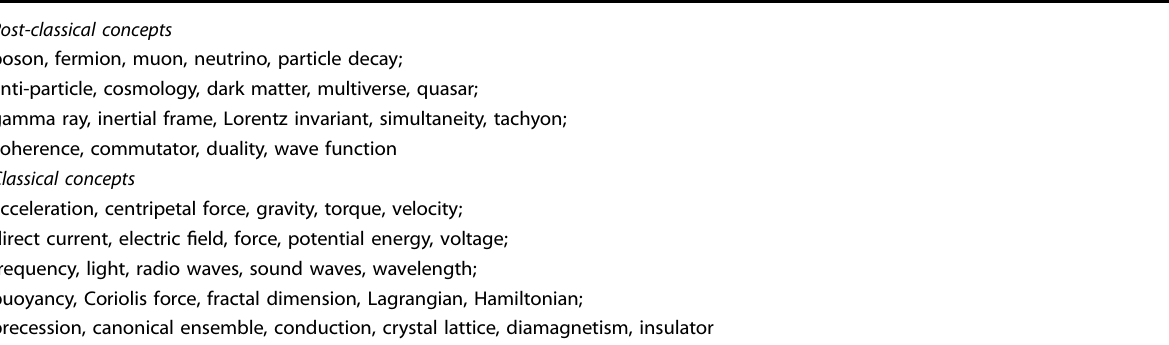
Table 1. The 45 stimulus concepts used in the study, drawn from various physics sub- fi elds. Post-classical